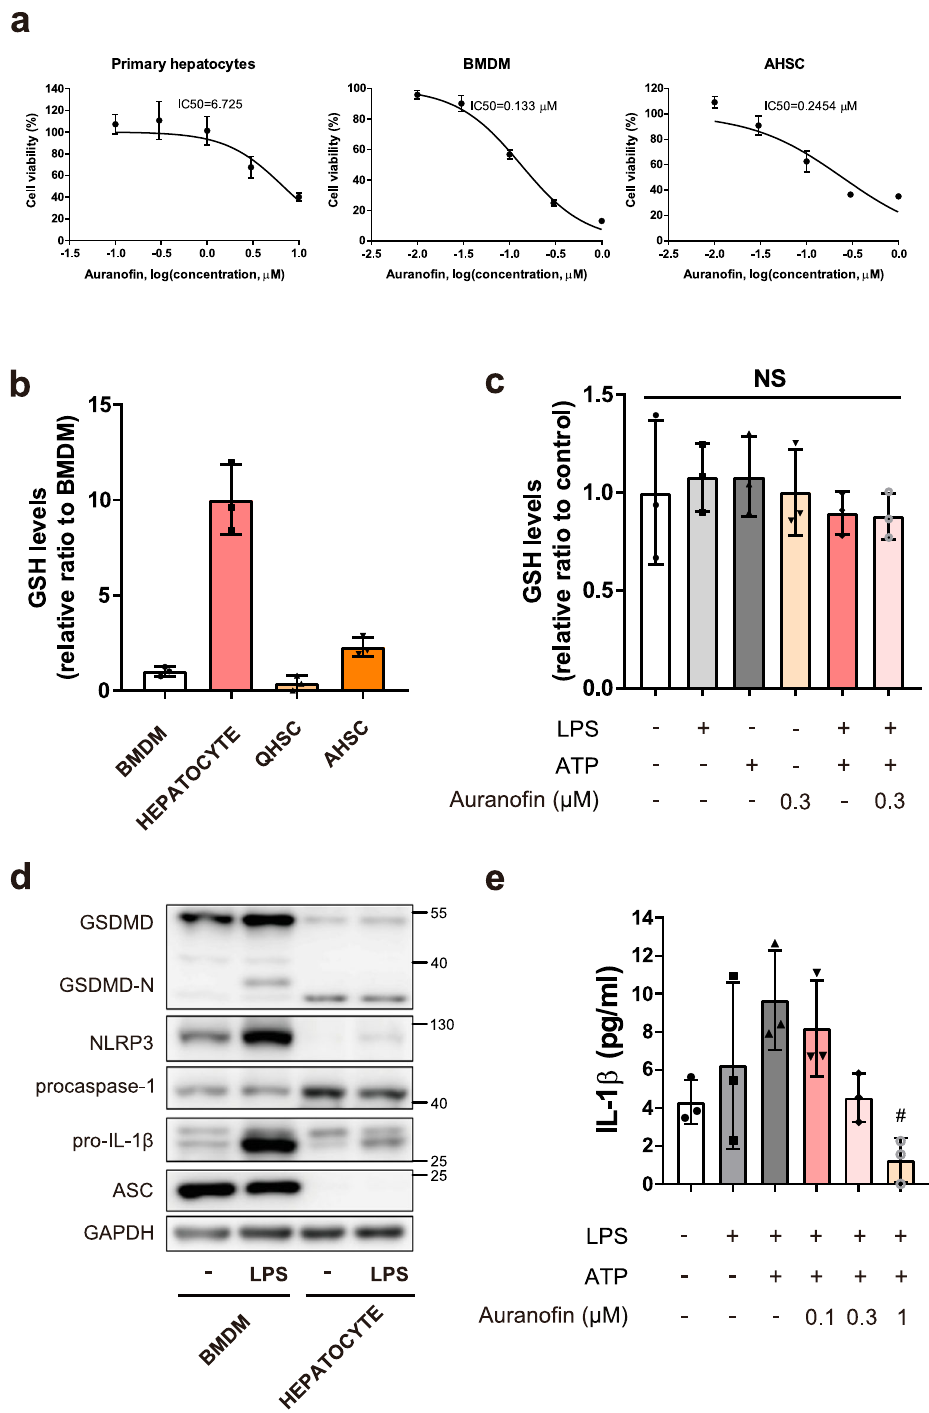
Fig. 6 Hepatocytes are resistant to the effects of aurano fi n. a IC50 values of aurano fi n were determined using MTT assay on mouse primary cells including hepatocyte, BMDM, and AHSC. AHSC; Activated hepatic stellate cell. n = 7, n = 5, and n = 4 per group for hepatocyte, BMDM and AHSC, respectively. b Intracellular GSH levels of hepatocyte, BMDM and HSCs, n = 3. QHSC; Quiescent hepatic stellate cell. c Intracellular GSH levels of primary hepatocytes followed by LPS (100 ng/ml), ATP (1 mM) and aurano fi n (0.3 µ M) treatment, n = 3. Data are presented as mean ± SD, analyzed by one-way ANOVA followed by Tuckey ’ s test. NS; not signi fi cant. d Protein levels of GSDMD, GSDMD-N, proIL-1 β , NLRP3, procaspase-1, and ASC were evaluated by western blot analysis. e Primary hepatocytes were primed with LPS (100 ng/ml) for 4 h, followed by exposure to ATP (1 mM) for 1 h. IL-1 β release by NLRP3 in fl ammasome activation was measured by ELISA. Data are presented as mean ± SD, analyzed by one-way ANOVA followed by Tuckey ’ s test. n = 3, # p < 0.05, compared to NLRP3 in fl ammasome-induced